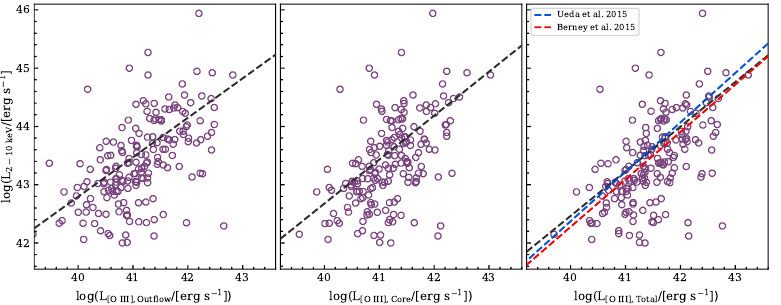
Figure 6. The correlation between L 2 – 10keV and [O III ] luminosity derived from the outflow compo- nent (broad, left ), core component (narrow, middle ) and total line profile ( right ). The black dashed lines in all panels present our linear regressions. The red and blue dashed lines indicate the best-fit relation obtained by Ueda et al. [58] and Berney et al. [59],